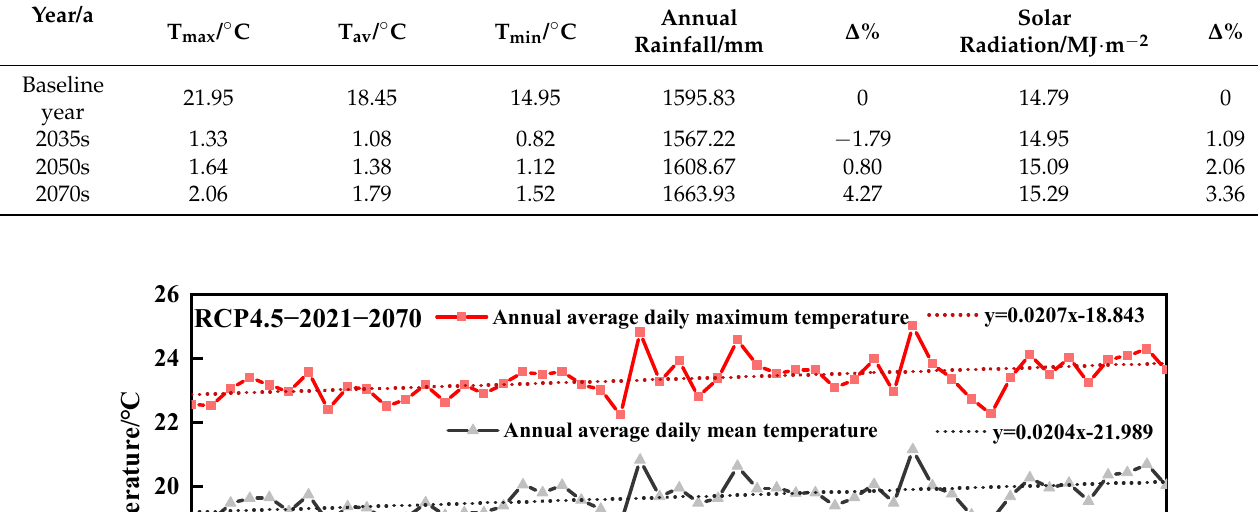
Table 4. Future Changes of Temperature, Rainfall, and Solar Radiation in Nanchang.